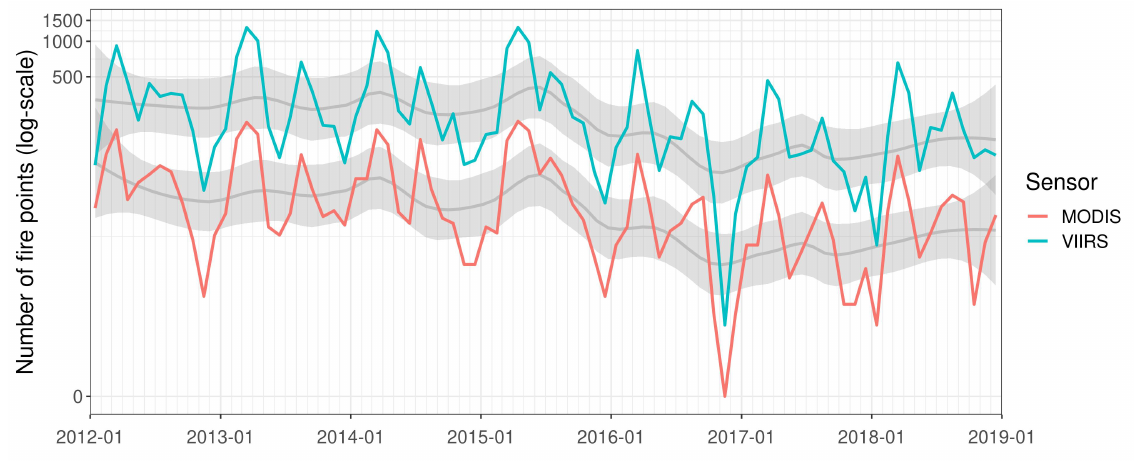
Figure S3 – Number of fire points per month sensed by MODIS and VIIRS sensors for the period 2012-2018